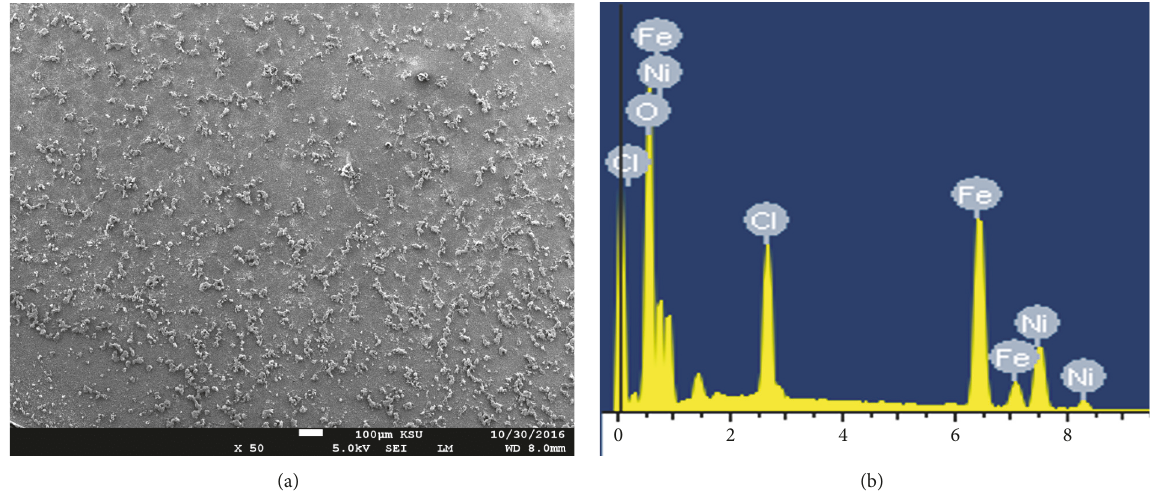
Figure 4: (a) SEM micrograph for the surface of the Fe-45% Ni alloy after its immersion in 1M HCl solutions for 96 h and (b) the corresponding EDS profile analysis shown in the SEM image.